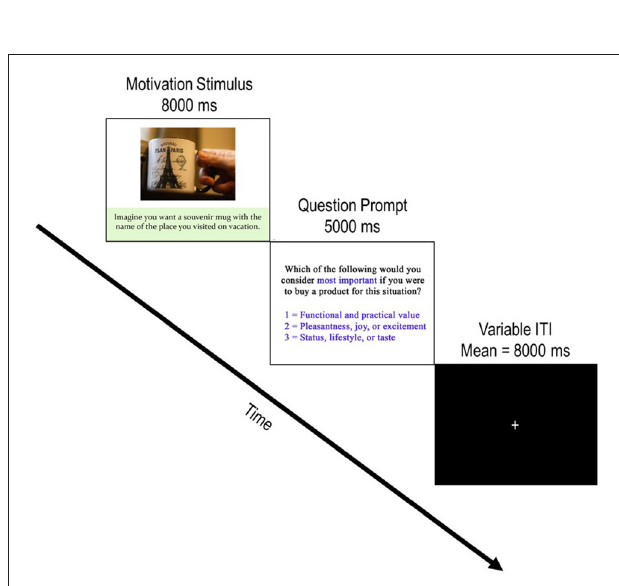
FIGURE 2 | Depiction of a typical trial progression. Each trial begins with the presentation of a product stimulus accompanied by a buying motivation scenario. After the motivation stimulus was presented for 8,000 ms, the question prompt screen appeared for 5,000 ms and incited participants to report which buying motivation they considered by pressing 1 of the three possible responses. Following the question prompt, a jittered ITI with a central fixation appeared. Participants were instructed to focus on the fixation cross and awaited the next trial during these periods. Note that the example image